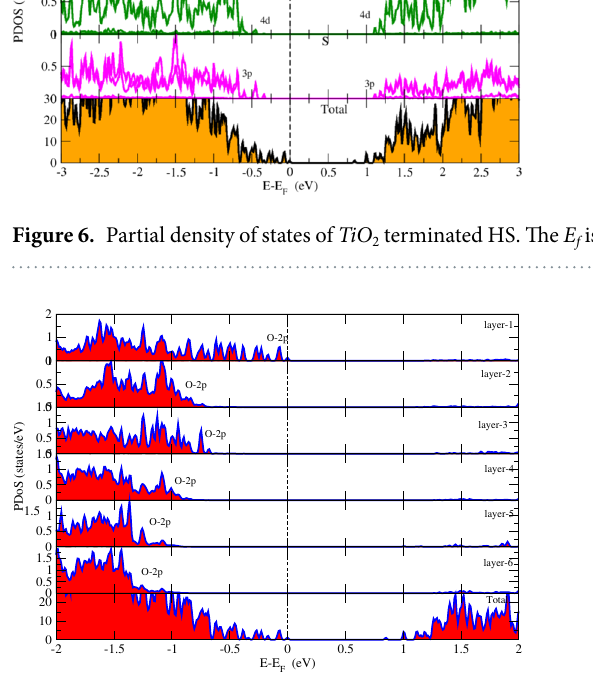
Figure 7. Partial density of states of O atom of each layer in TiO 2 terminated HS. The E f is set to